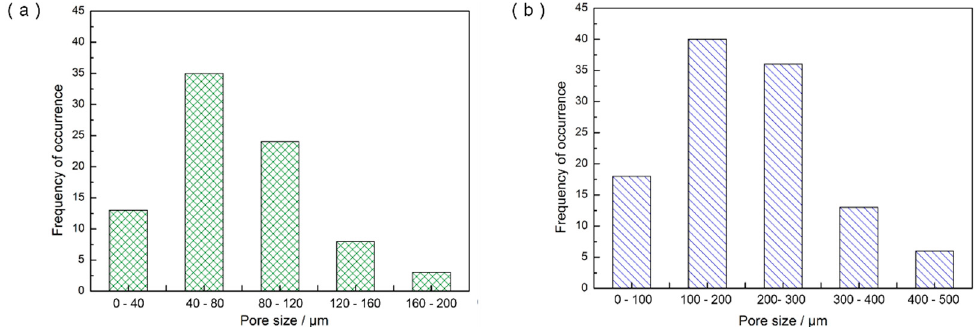
Figure 8. Statistical results of porosity size distribution in laser welding NS-Mo alloy joints produced under: ( a ) heat input 250 J/cm; ( b ) heat input 3600 J/cm.